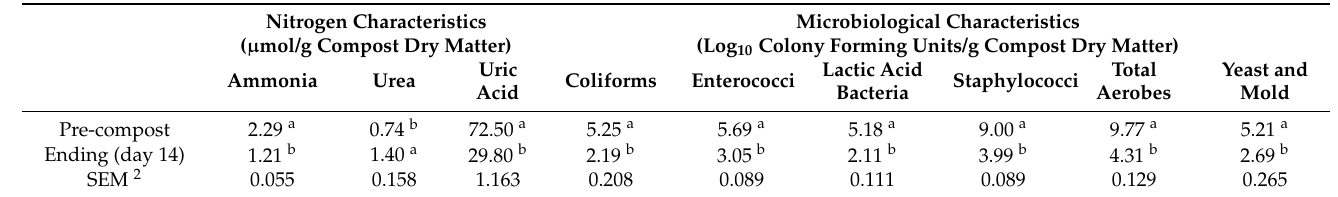
Table 4. Main effect means of day of composting on concentrations in Experiment 3 of nitrogen and select microbiological populations after 14 days of simulated composting of a 3:1 mixture of wood chip poultry litter and ground bluestem hay 1